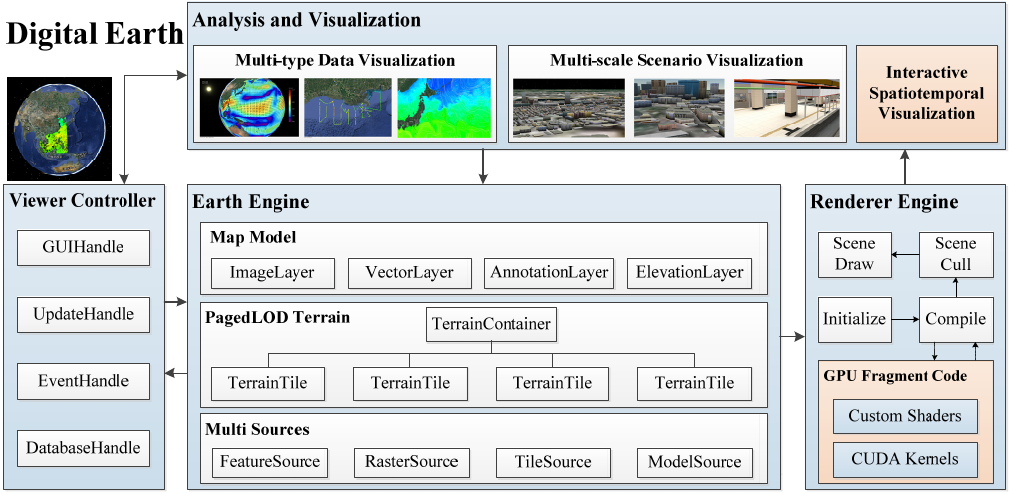
Figure 3. Digital earth implementation architecture